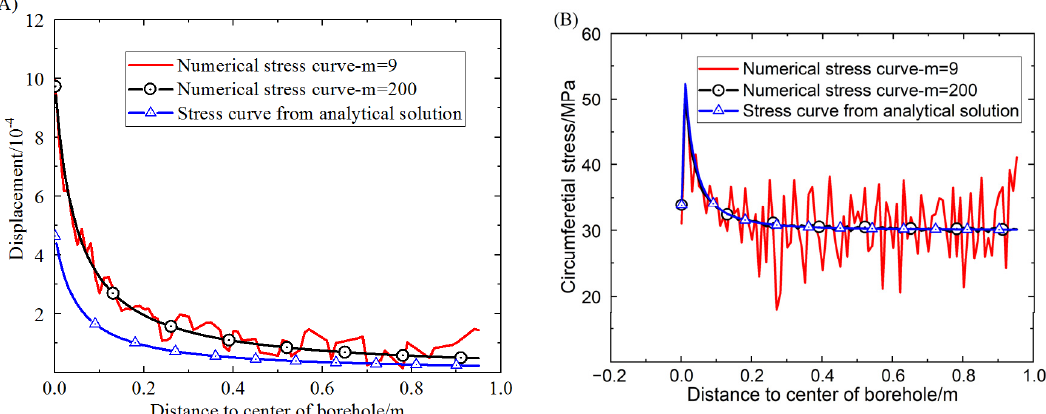
Figure 10. Comparison of displacement and circumferential stress distribution between the analytical solution and the proposed damage model at different homogeneities.